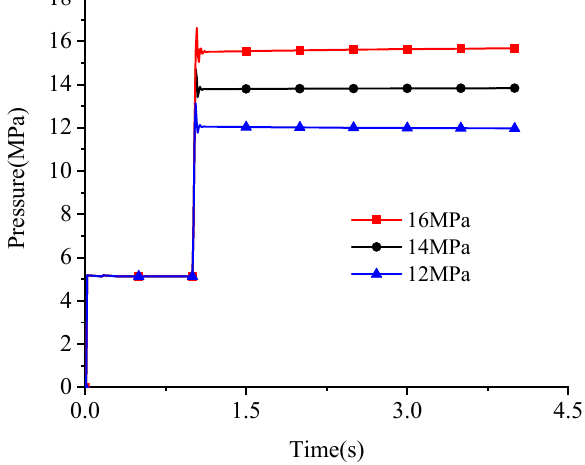
Figure 16. The pressure step response curve.